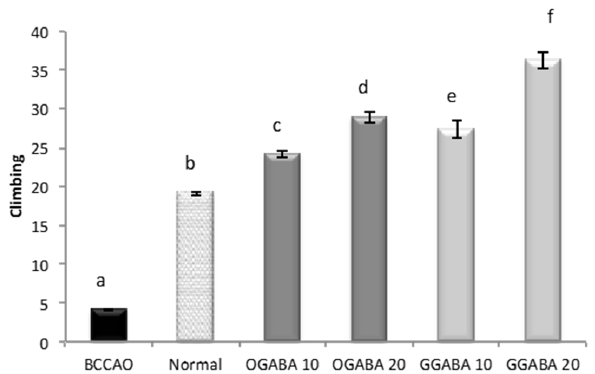
Figure 5. Effects of oral administration of OGABA and GGABA extracts on climbing time in forced swimming model. Data are mean(s) ± SD ( n = 7); different letters indicate statistically significant differences ( p < 0.05) between the two groups.